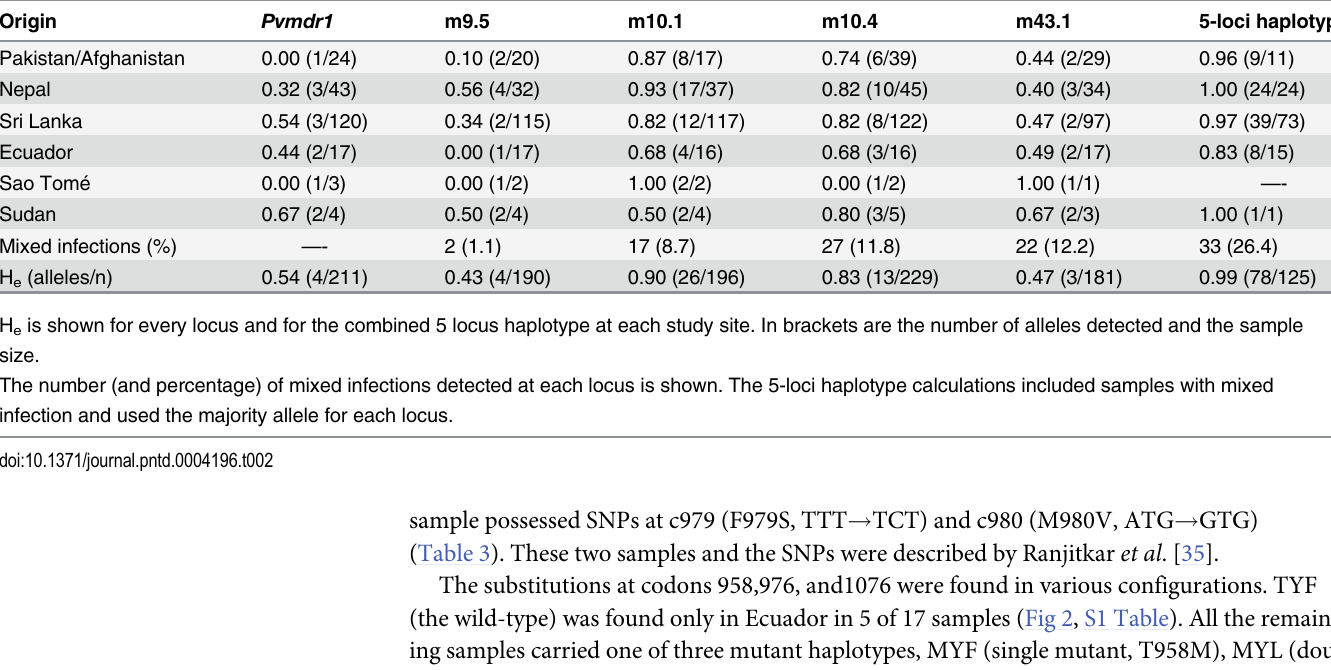
(Table 3). These two samples and the SNPs were described by Ranjitkar et al . [35]. The substitutions at codons 958,976, and1076 were found in various configurations. TYF (the wild-type) was found only in Ecuador in 5 of 17 samples (Fig 2, S1 Table). All the remain- ing samples carried one of three mutant haplotypes, MYF (single mutant, T958M), MYL (dou-